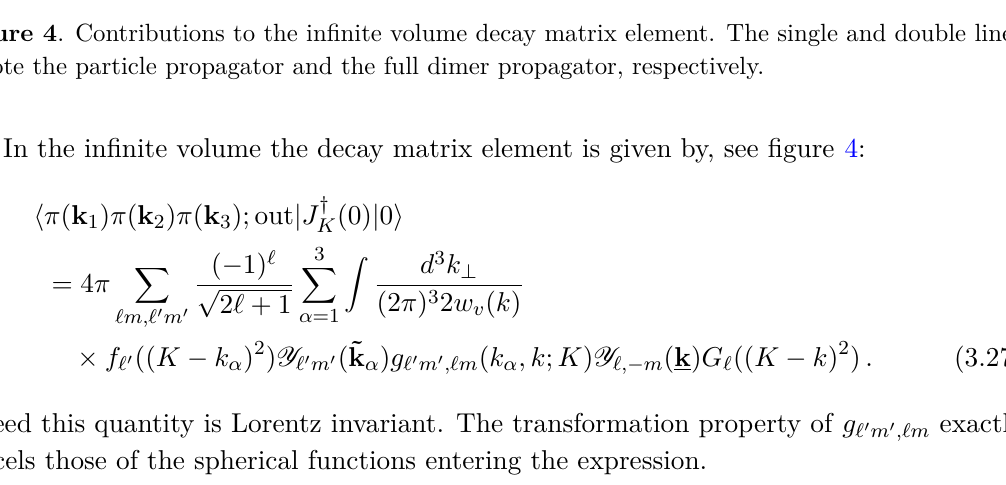
Figure 4 . Contributions to the infinite volume decay matrix element. The single and double lines denote the particle propagator and the full dimer propagator,